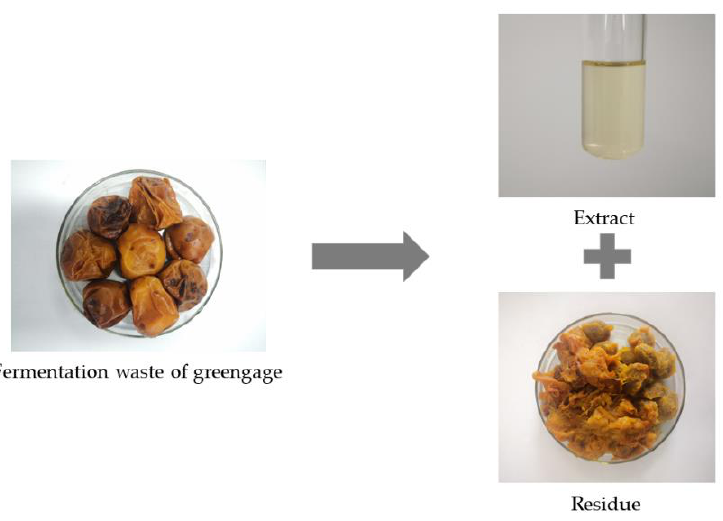
Figure 1. The fermentation of greengage waste and its extract.